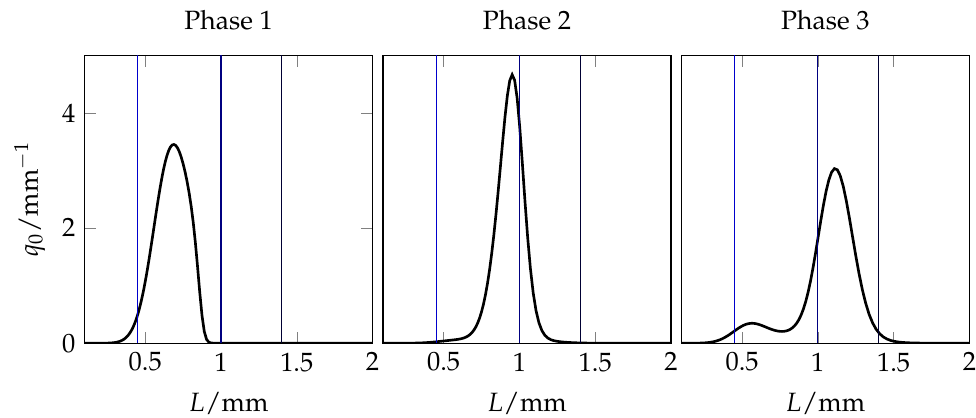
Figure 5. Normalized number density distributions q 0 ( L ) during the oscillation cycle described above with L mill = 0.45 mm. The vertical lines mark the milling diameter as well as the product and oversize sieve